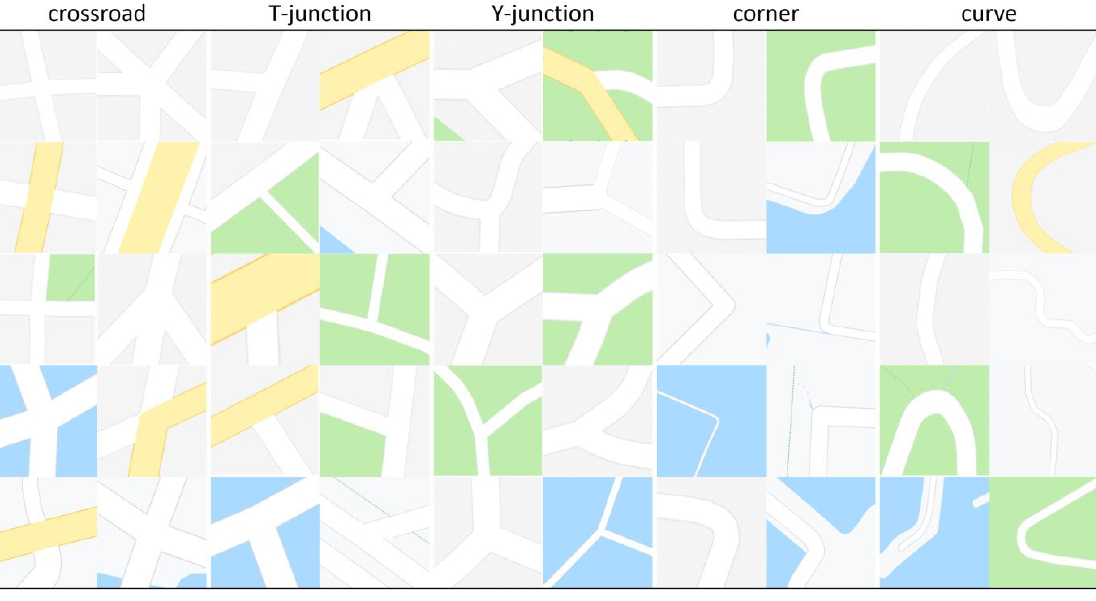
Figure 4. Samples of five types of road characteristics retrieved from Google roadmap.